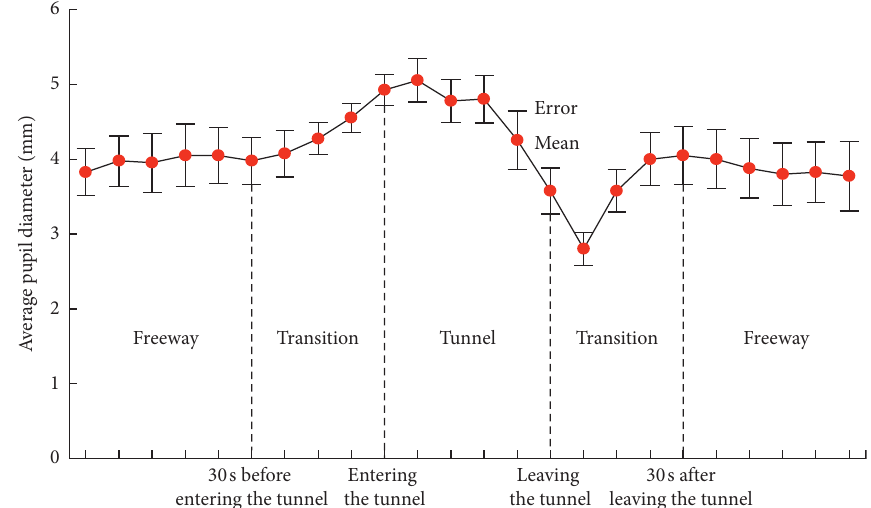
Figure 3: Changes in average pupil diameter during driving through a tunnel.